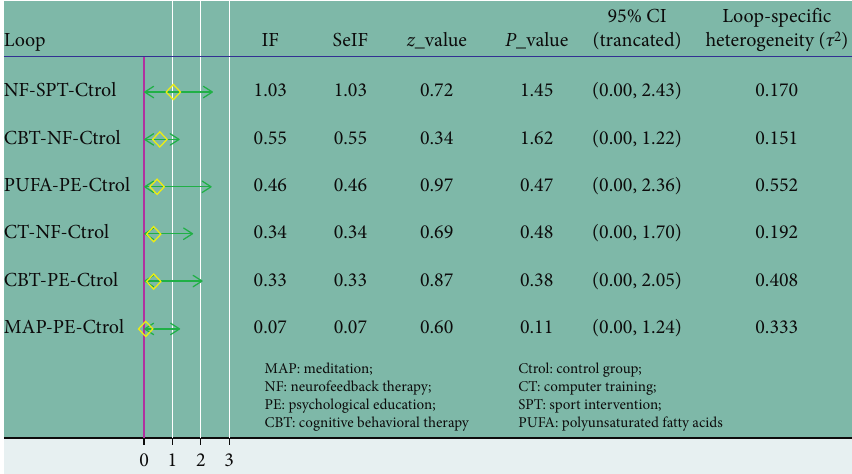
Figure 3: Loop inconsistency